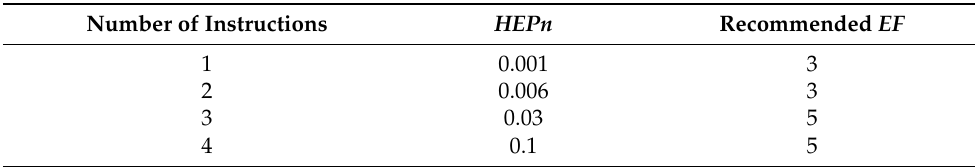
Table 9. HEP and EF values for the communication